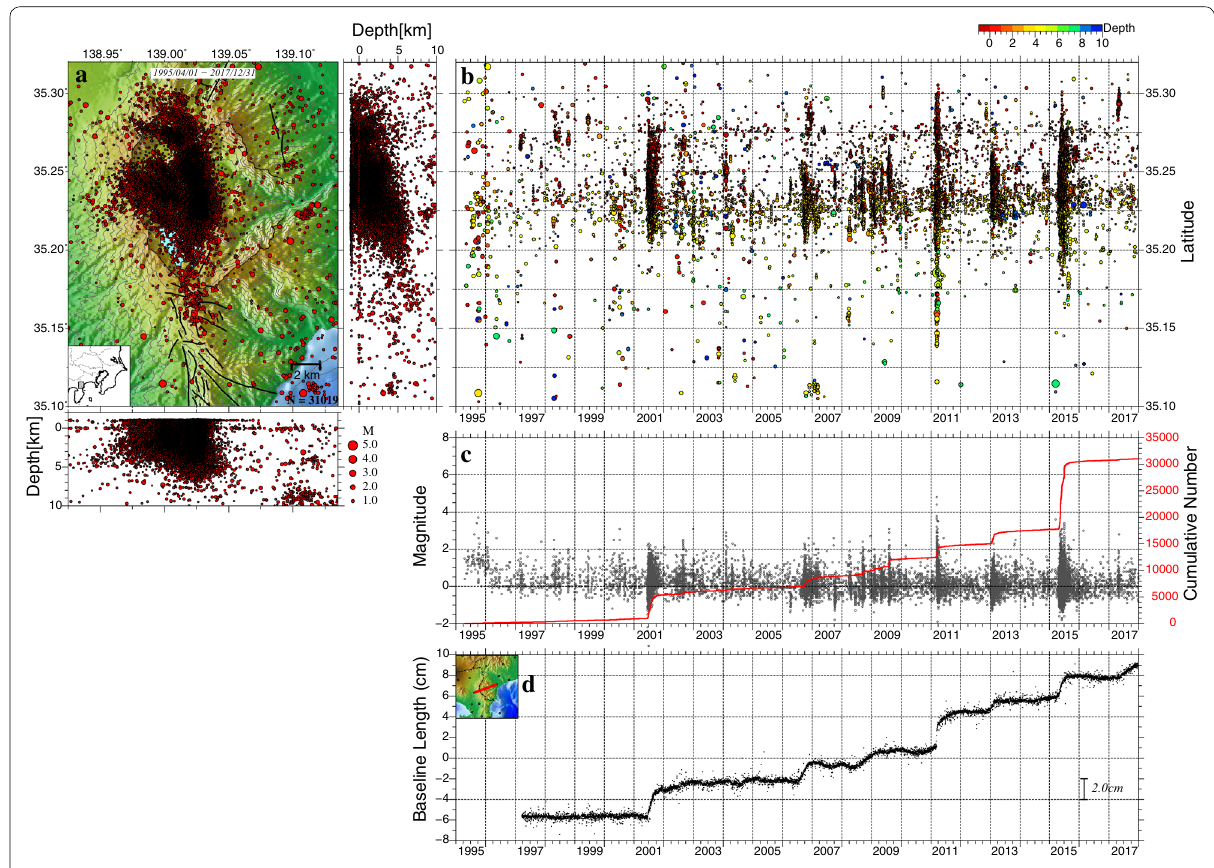
Fig. 2 Seismic activity and inflation of Hakone volcano from April 1995 to December 2017. The hypocenters were determined by HSRI. a Hypocentral distribution of Hakone volcano. b Spatiotemporal seismicity change. The vertical axis represents latitude. c Magnitude–time diagram and cumulative number of earthquakes. d Baseline length change between the Odawara and Susono-2 GEONET stations. The major volcanic earthquake swarm periods were observed in 2001, 2006, 2008–2009, 2013, and 2015. The elevated seismic activity in 2011 was triggered by the 2011 Tohoku Earthquake